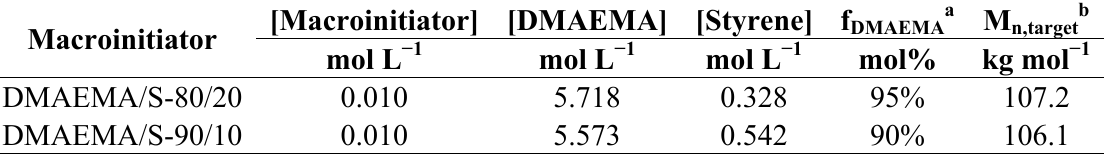
Table 2. Experimental conditions of the chain extension experiments at 80 °C in